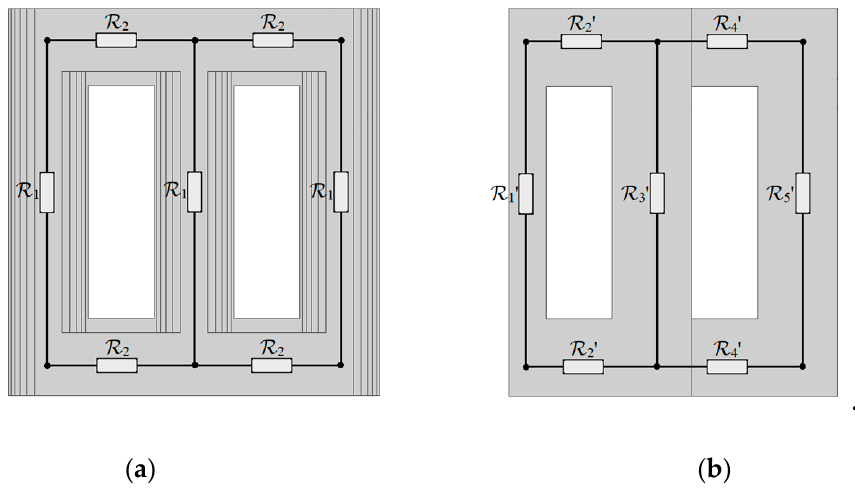
Figure 8. The reluctance network of the 3D model ( a ) and 2D model ( b ).